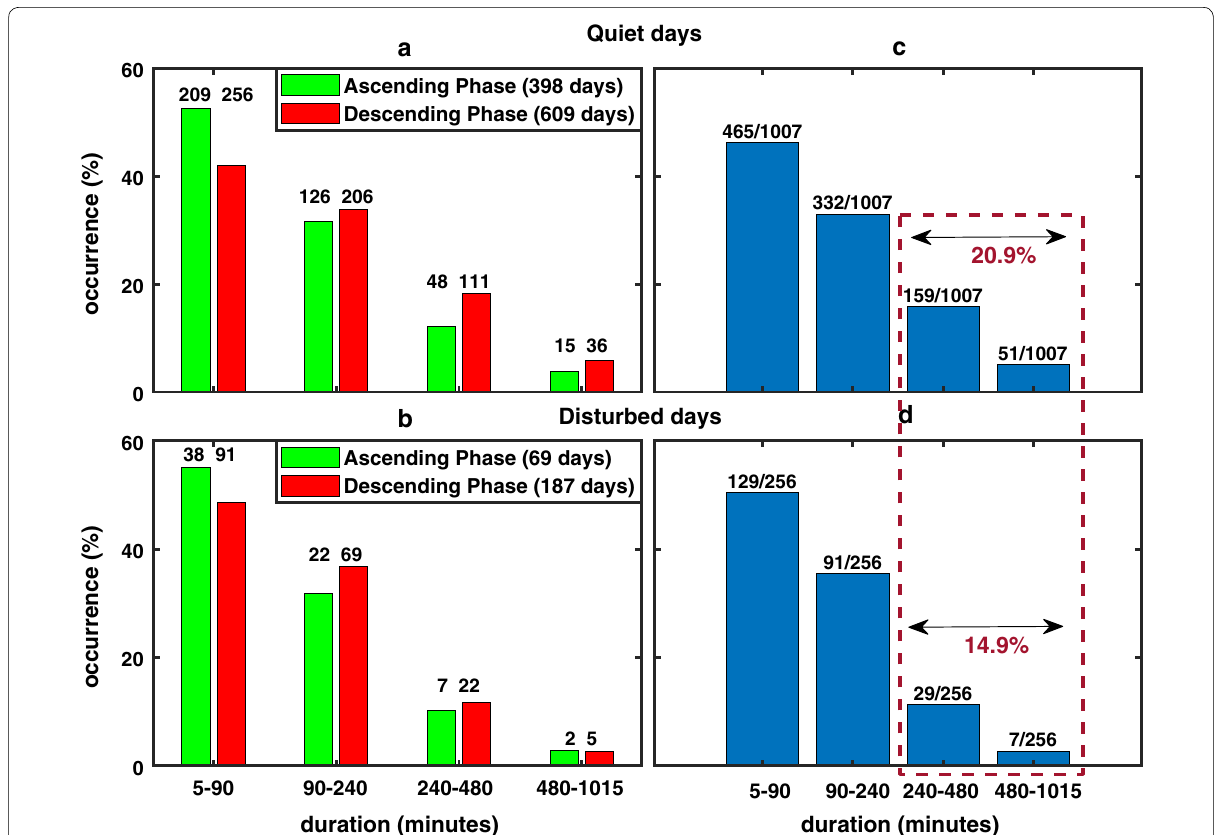
Fig. 7 Distribution of EMIC waves with different daily duration bins namely, 5–90 mins, 90–240 mins, 240–480 mins and 480–1015 mins are shown for a quiet days and b disturbed days of the ascending (green) and descending (red) phases of solar cycle 24. The similar distribution of EMIC wave duration for the total period of 2011–2017 are depicted in c and d for quiet and disturbed days, respectively. The numbers on the top of each bar denote the days for which the EMIC wave occurrence was seen in the corresponding categories. There are total 1007 quiet and 256 disturbed days. Occurrence of events with longer durations are marked by dotted